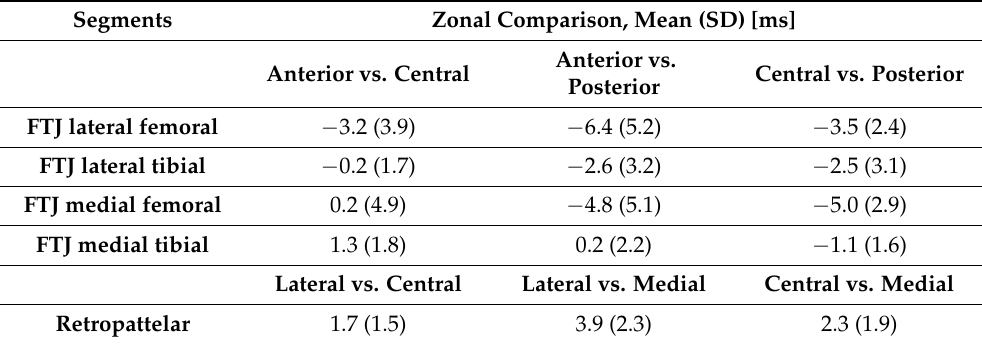
Table 3. Zonal comparison of mean intrachondral T2* time (ms) with SD in the FTJ and retropatellar. Segments Zonal Comparison, Mean (SD)